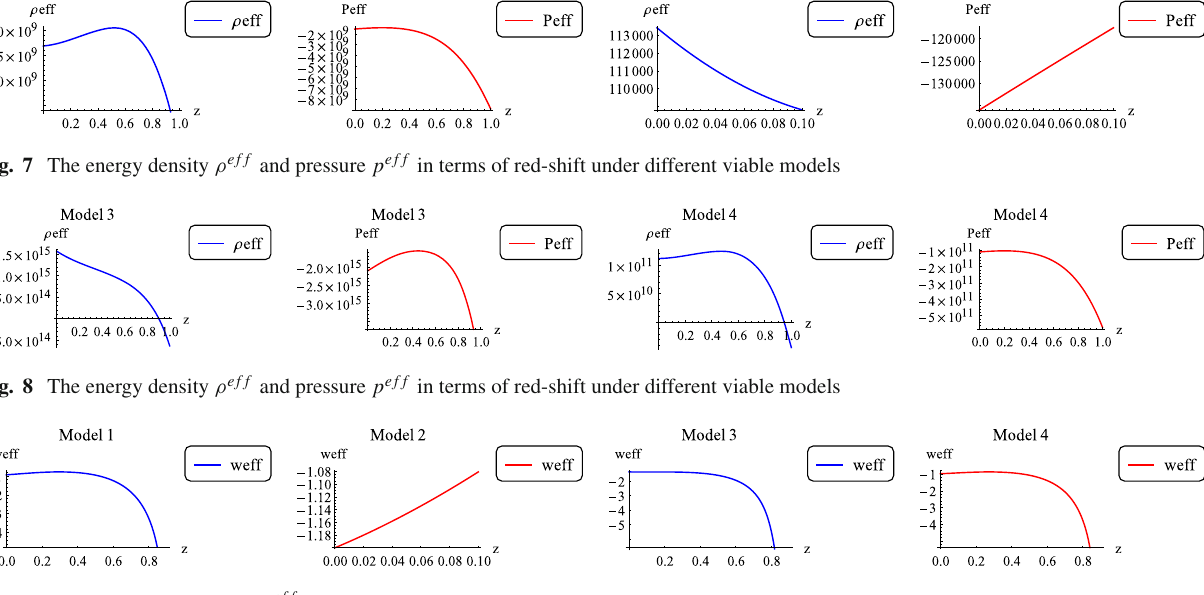
Fig. 9 The parameter of EoS is ω ef f in terms of red-shift under different viable models